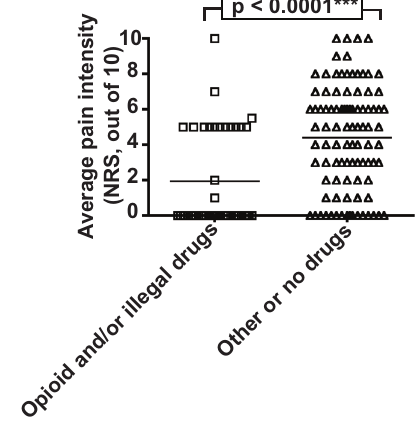
Figure 2. Pain intensity reported by homeless people categorised by drug use. Scatter plot to show the severity of average pain reported by homeless people who either take prescribed opioids, non-prescribed opioids, or cannabis; or those who take over the counter non-opioid analgesics or no drugs. Bars indicate means. Data compared using Mann-Whitney test.